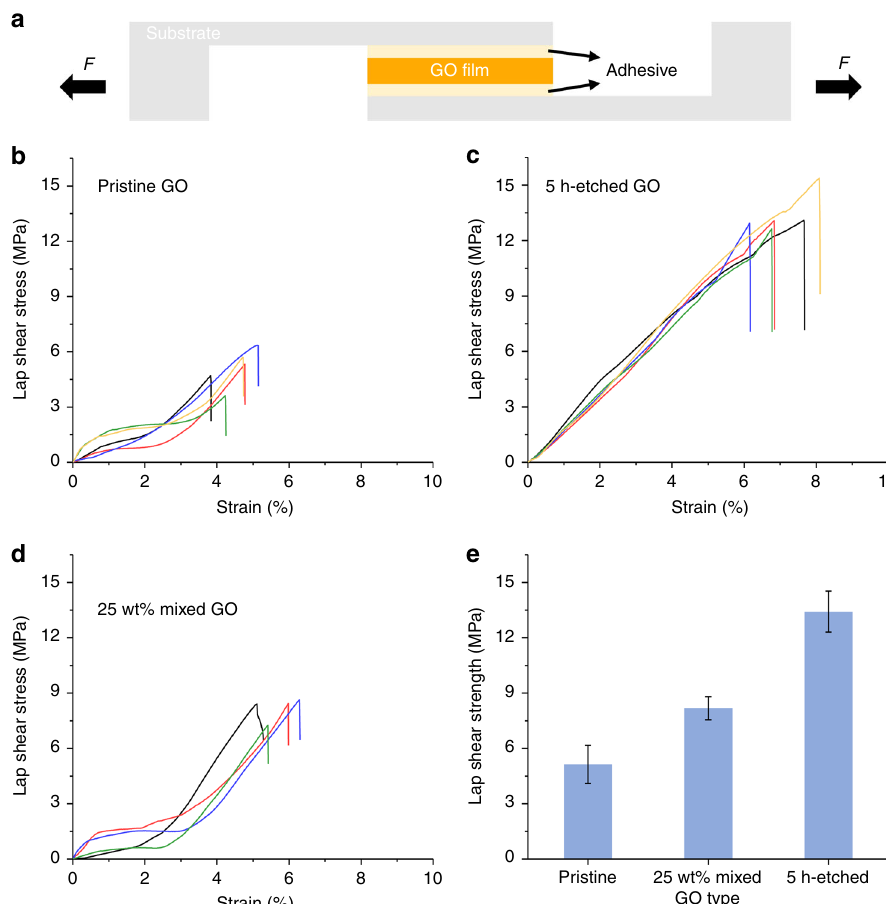
Fig. 5 Lap-shear tests of GO fi lms. a Schematic drawing showing the experimental con fi guration of the lap-shear test. A rectangular GO fi lm (3 × 4 mm, around 10 µ m thick) was glued between two parallel glass substrates using an epoxy adhesive. A shear stress was then applied by pulling the substrates in the opposite direction at a speed of 0.3 mm min − 1 up to fi lm delamination. Shear stress – strain curves of fi lms made of b pristine, un-etched GO, c 5-h- etched porous GO, and d pristine GO mixed with 25 wt% of 5-h-etched GO. For each type of GO fi lm, 4 – 5 samples were tested. For all the samples shown here, delamination occurred from within the GO fi lm, rather than at the adhesive-GO or adhesive-glass interfaces. e Summary of shear strength values for all measurements in b – d . Error bars represent adhesive. Next, shear stress was applied by pulling the slides in the opposite direction at a rate of 0.3 mm min − 1 . In all cases, the fi lms were delaminated from within the GO fi lm rather than from the GO/adhesive or adhesive/glass interface, so that the mea- surement re fl ects the interlayer binding strength within the GO fi lm. Figure 5b – d shows the lap-shear stress – strain curves of the three GO fi lms, with 4 – 5 tests each. The values of the lap-shear stress at delamination are summarized in Fig. 5e. Films made of 5-h-etched sheets are found to have the highest shear strength (13.4 ± 1.1 MPa) and exhibit relatively simple elastic behaviors before delamination without any obvious plastic deformation (Fig. 5c). This is consistent with a uniform propagation of the shear deformation throughout the fi lm, indicative of a tight interlayer binding between the porous sheets. In contrast, fi lms made of pristine, un-etched GO sheets have the lowest shear show evidence of initial fl ow before reaching a deformation state similar to the elastic state observed in the 5-h-etched sample. This behavior implies that the pristine GO sheets experience partial made from un-etched, pristine sheets, neat 5-h-etched sheets, and interlayer sliding and rearrangement at the initial stage of shearing that eventually leads to a more “ tightly bound ” state. The mobility of the GO sheets during this stage of rearrangement could be facilitated by the presence of the architectural defects